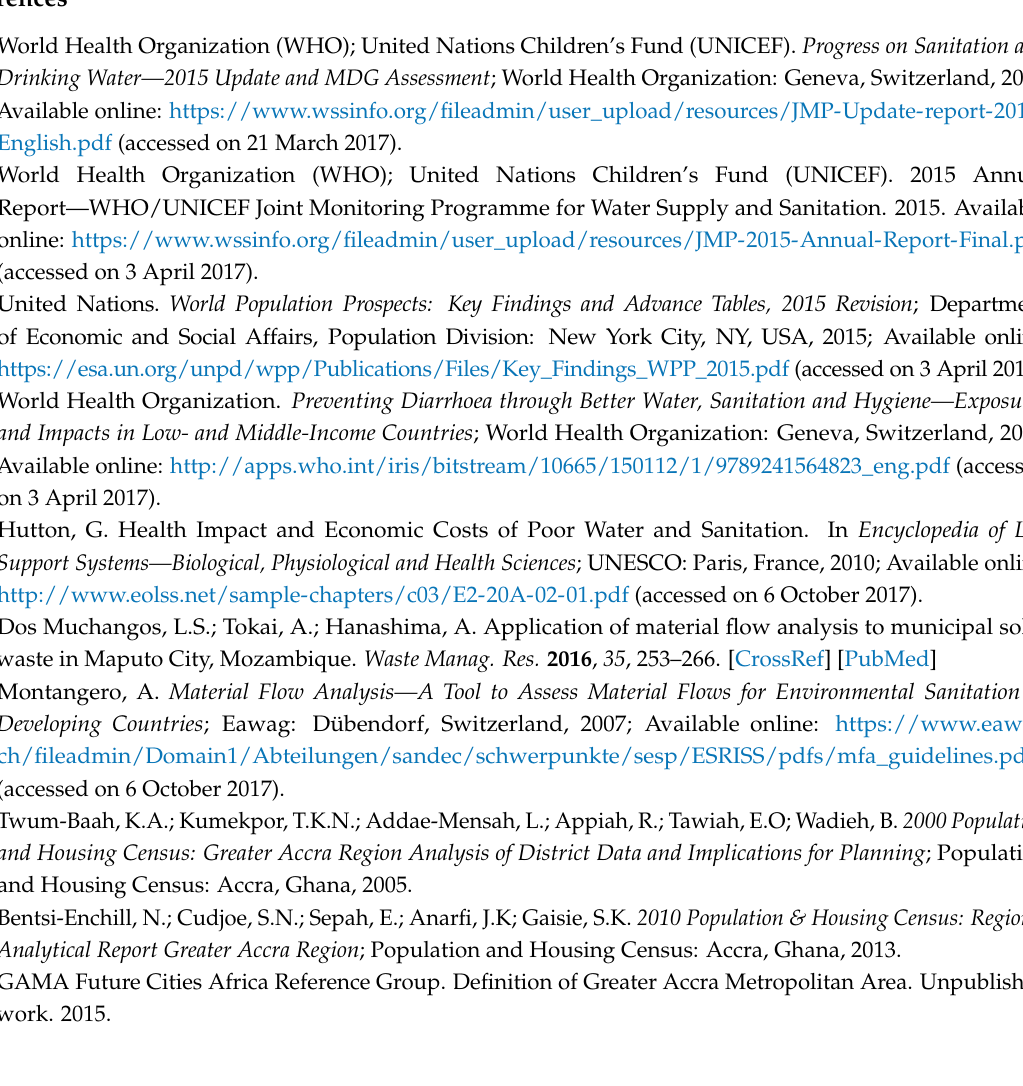
m 3 from 1980–2015, Figure S2: Total domestic water use estimate in GAMA per district for 2010 by supply source, Figure S3: Total wastewater and human excreta generation estimate in GAMA per district for 2010 by sink, Figure S4: Proportion of wastewater and human excreta ending up in the environment and collected via sewage pipes and cesspit-tankers); Supplementary Material C (containing Table S2: Water consumption in litres per capita per day by income, water sourcing, and rationing from secondary sources plus estimates, Table S3: Proportion of population with central pipe access in rationed areas and with continuous supply and final % of central water distribution per district, Table S4: Proportion of wastewater discharged onto local soils λ q = 1 , into open drains λ q = 2 , and into sewage pipes λ q = 3 , Table S5: Population proportion parameter values µ _r for use of toilet types and defaecation practices, Table S6: Toilet use proportions in GAMA districts as per the 2010 population census, Table S7: Parameters established for the material flow analysis.); Supplementary Material D (containing Table S8: Literature overview of studies on human urine excretion, Table S9: Literature overview of studies on human faeces